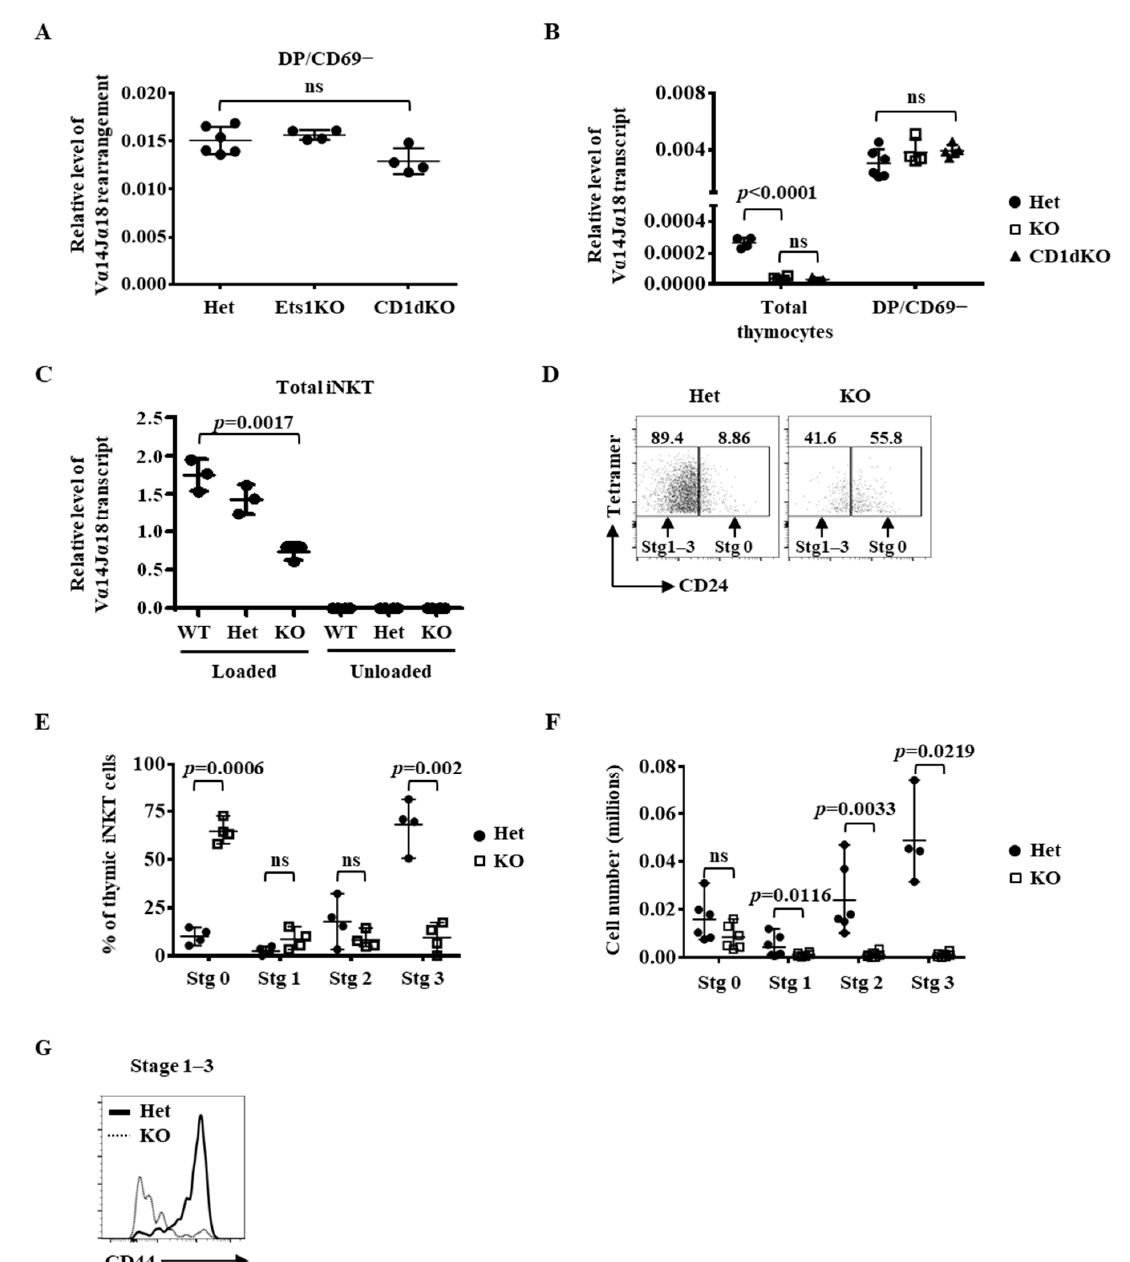
Figure 1. A dispensable role of Ets1 in the expression of V α 14J α 18 TCR in thymic iNKT precursors and their selection. A-C. Genomic DNA ( A ) and cDNA ( B , C ) were prepared from total thymocytes ( B ), sorted CD69 − DP thymocytes ( A , B ), and total iNKT cells ( C ) of indicated genotype and subjected to quantitative PCR using primers corresponding to the V α 14 and J α 18 regions. ( D – G ) Thymic iNKT cells were identified with TCR and loaded CD1d tetramer and then subsequently separated into stage 0 and stage 1–3 based on the level of CD24 ( D ). Stage 1–3 cells were further fractionated into stage 1, 2, and 3 based on the expression of NK1.1 and CD44. The percentage of each stage of iNKT cells among total iNKT cells and their absolute numbers were calculated and are shown in E and F, respectively. G. CD44 staining of stage 1–3 iNKT cells is shown. The data shown in Figure 1 are compiled from at least three pairs of mice.